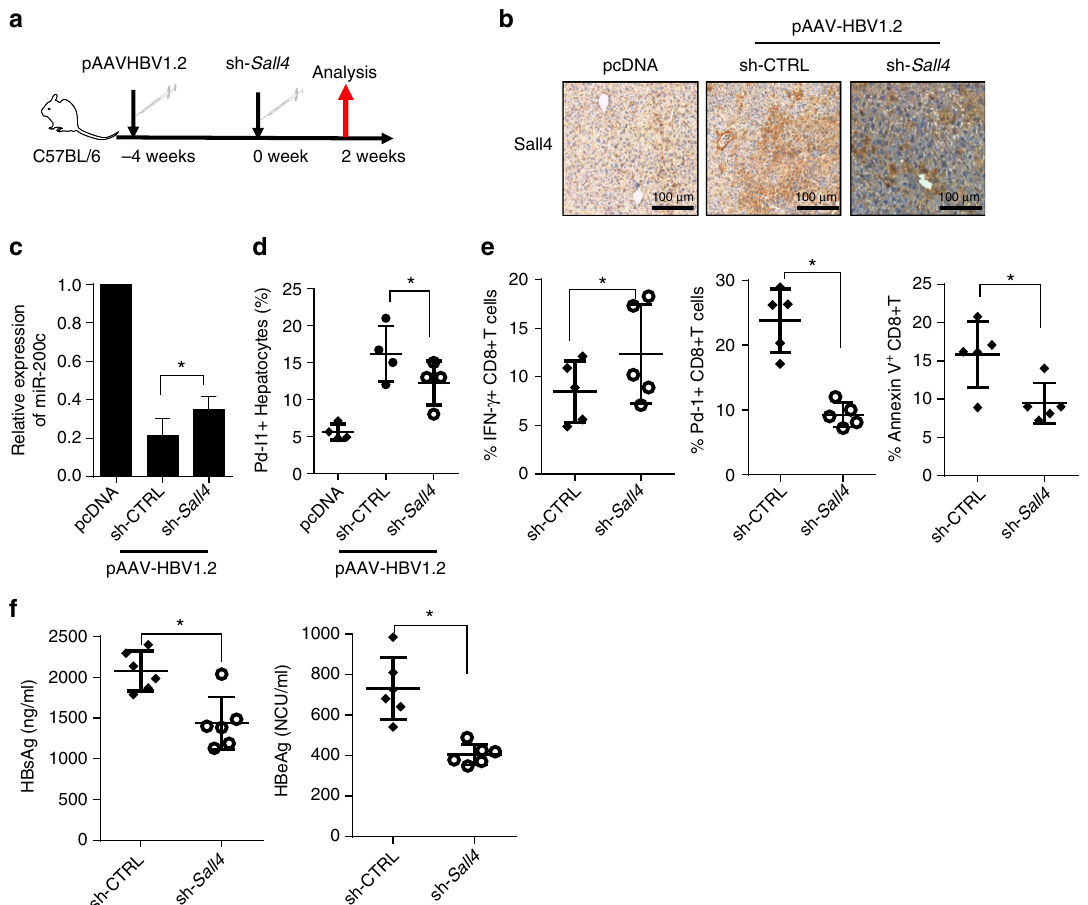
Fig. 8 Silence of SALL4 hinders HBV persistence through miR-200c-PD-L1-T cell exhaustion. a Protocol of Sall4 silence in HBV-persistent mice. pAAV/HBV1.2 was injected into C57BL/6 mice, and four weeks later, sh- Sall4 or sh-ctrl was hydrodynamically injected into HBV-persistent mice, and then analyzed two weeks later. b The protein levels of Sall4 in liver were detected by IHC in HBV-persistent mice after sh- Sall4 treatment. c miR-200c expression was determined by q-RT-PCR in primary hepatocytes from Sall4 -silenced HBV-persistent mice. d Pd-l1 expression was assayed by FACS in the same cells as above. e The percentage of IFN- γ -, Pd-1-, and Annexin V-positive CD8 + T cells was determined from liver of Sall4 -silenced HBV-persistent mice. f The serum levels of HBsAg and HBeAg in Sall4 -silenced HBV-persistent mice were detected by ELISA. Data are representative of three